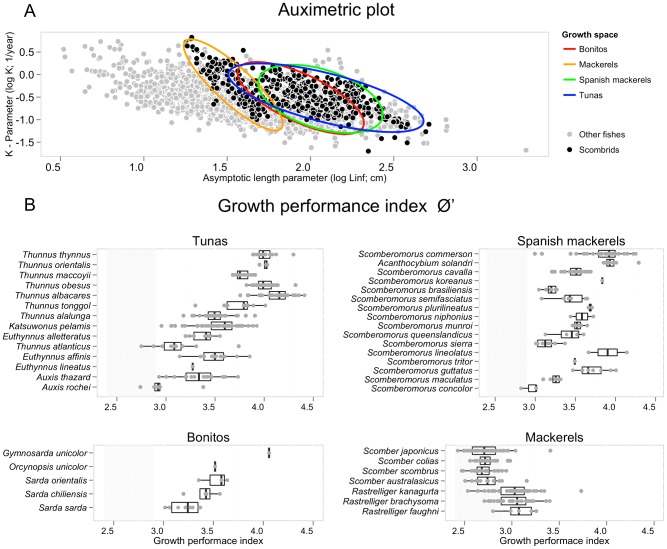
Growth performances in scombrid species including all fishes in FishBase, illustrating the high growth performances of scombrids.(A) Auximetric plot comparing the growth performance of scombrid species (black circles) with that of fishes in general (grey circles). Fish data extracted from FishBase as August 2012. The growth space for the main four taxonomic groups of scombrids, tunas, bonitos, Spanish mackerels and mackerels, are also illustrated (colored ellipse curves). (B) The growth performance index Ø′ (defined as Ø′ = log10
k+2log10
L∞) of scombrid fishes compared with the average growth performances in fishes in FishBase (average growth performance is 2.7±0.3, grey band area).